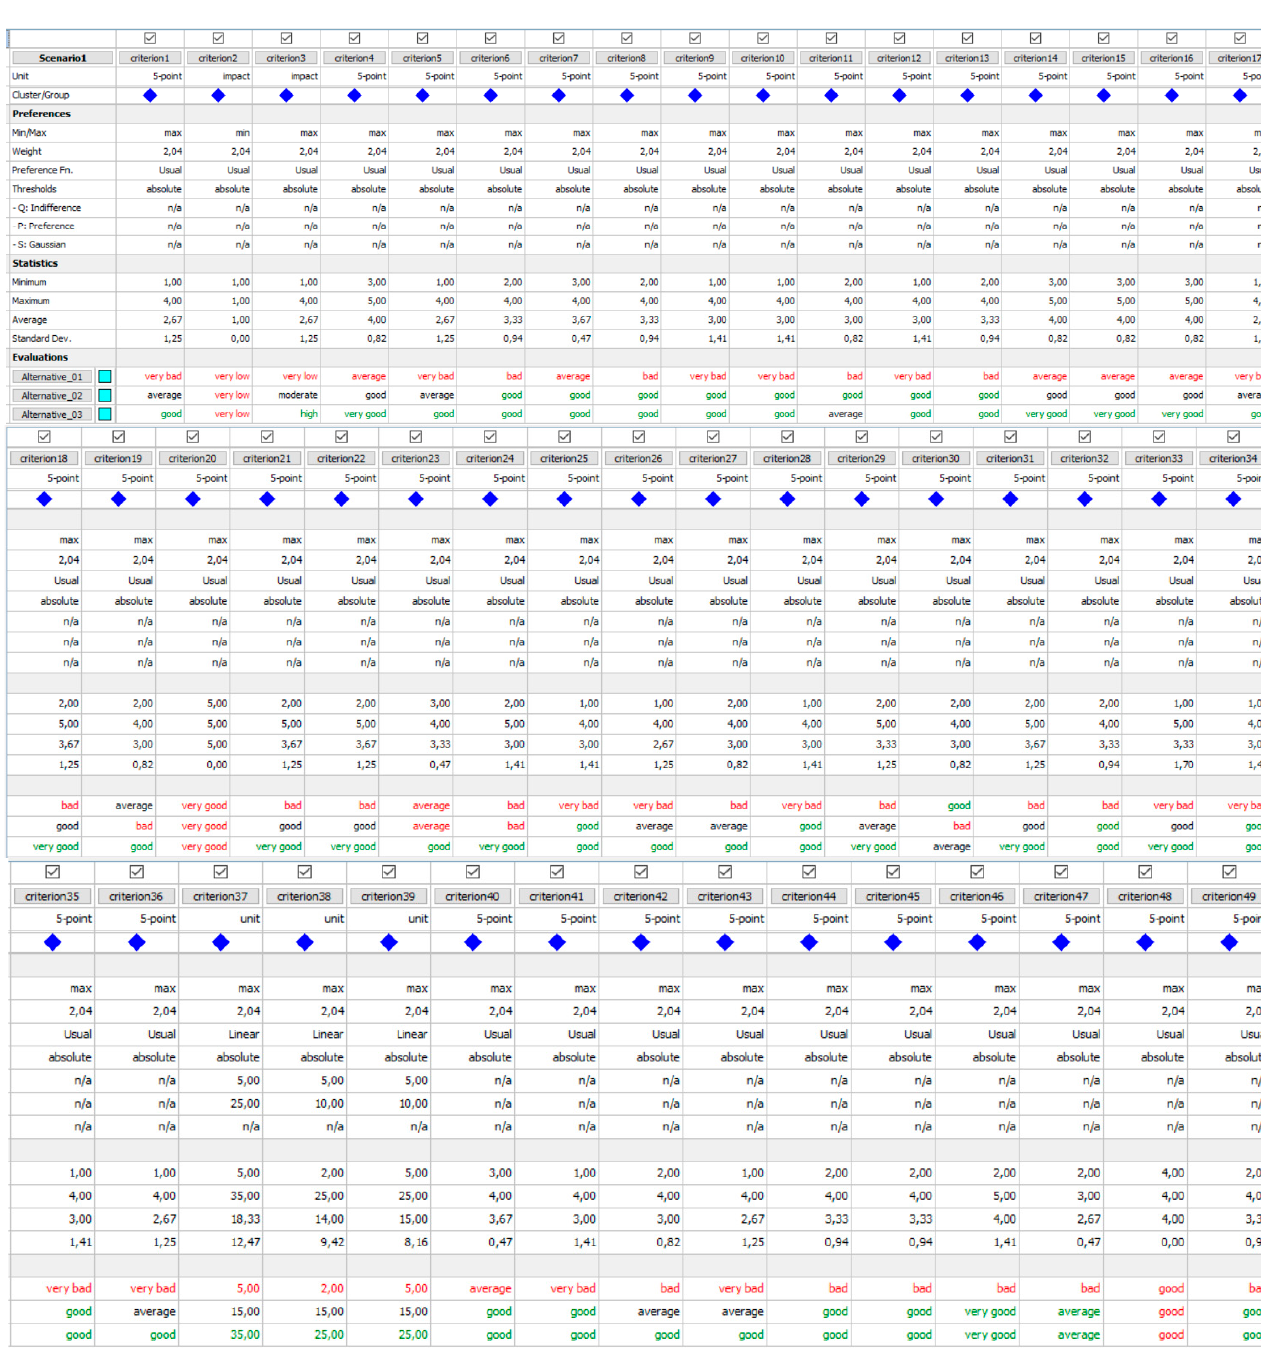
Table A1. Holistic Implementation Guidelines for lower levels of spatial planning, urban and build- ing design.